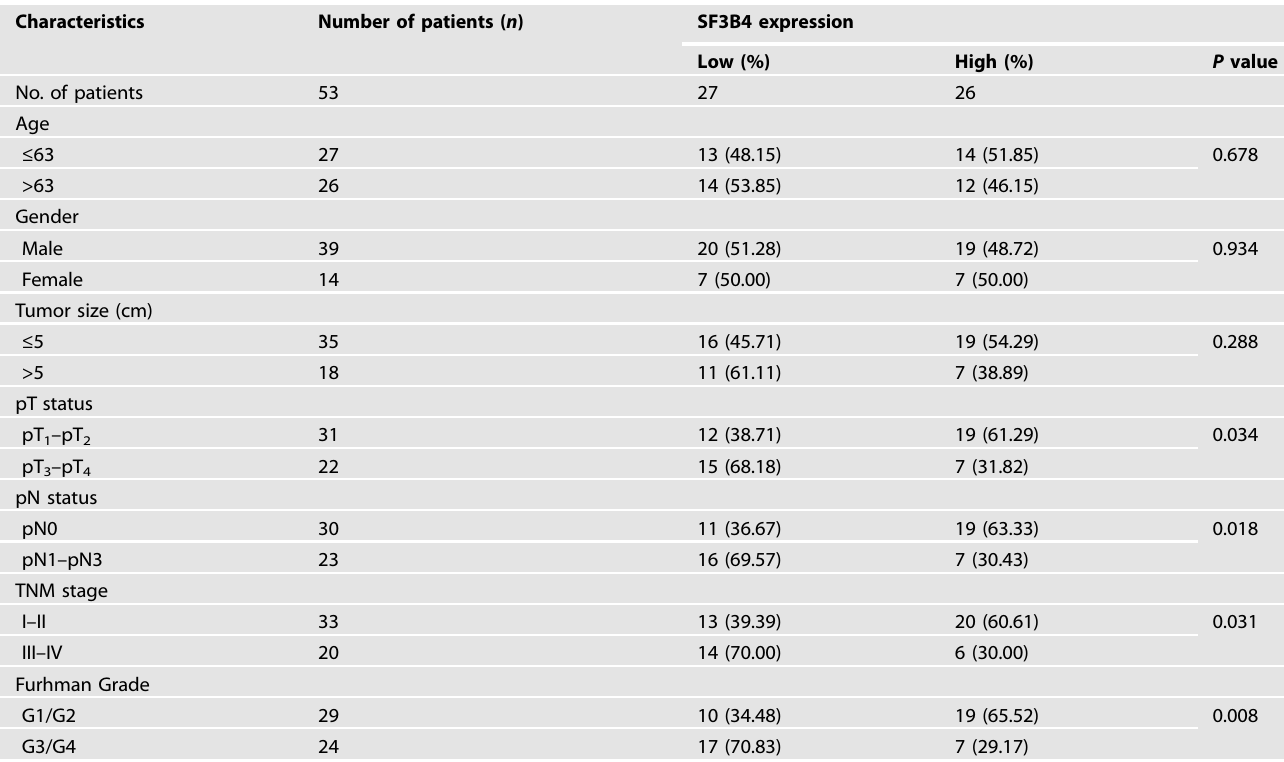
Table 1. Clinicopathological